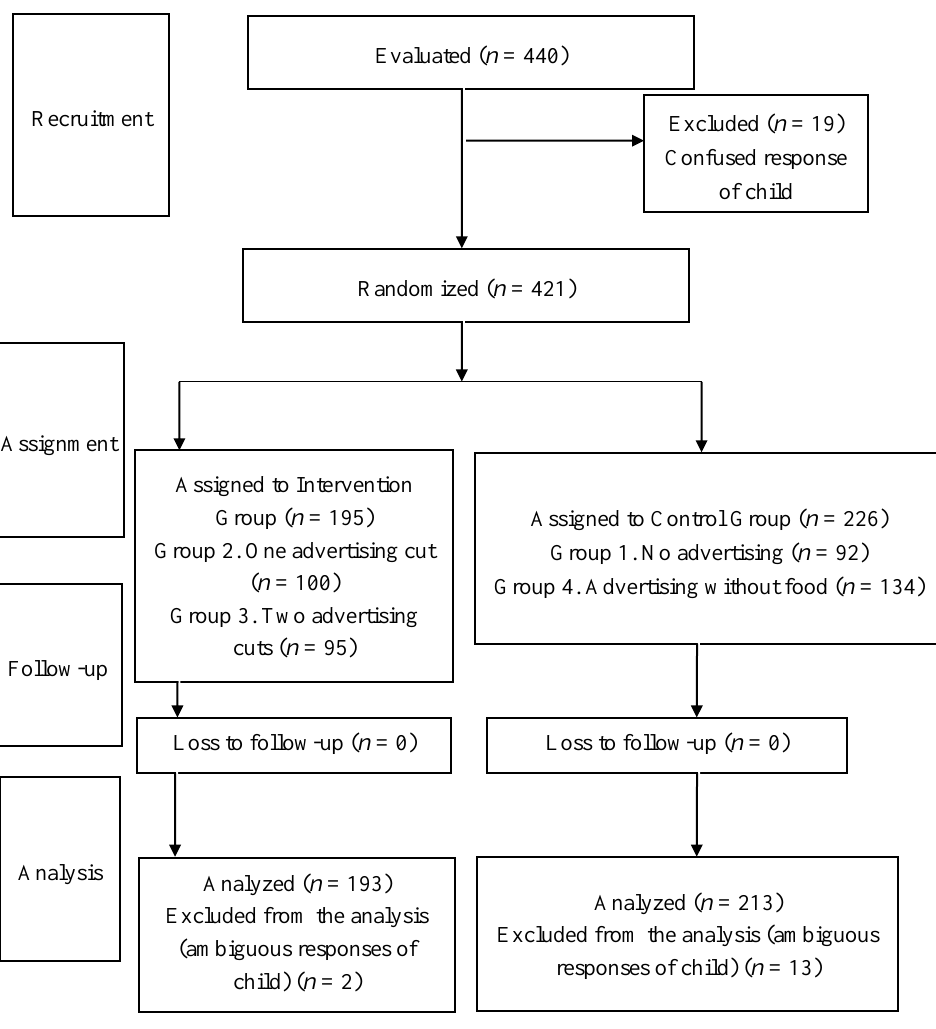
Figure 1. CONSORT flow diagram.